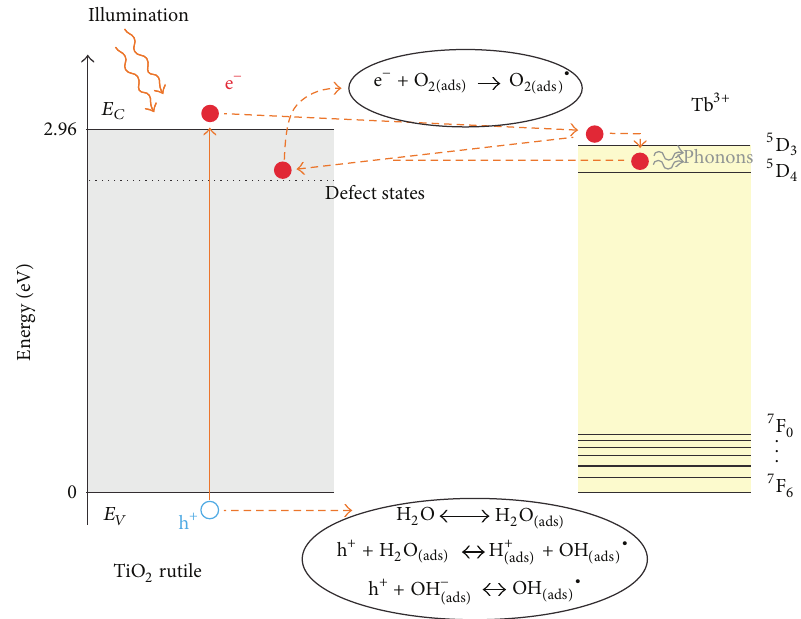
Figure 6: The scheme of processes proceeding at the TiO 2 :Tb surface with rutile structure. Designations: 𝐸 𝑐 , 𝐸 V , energy of the bottom edge of the conduction band and the top of the valence band, respectively; e − , electron; h + , hole; O 2 , oxygen; O 2∙ , oxygen radical; H 2 O, water; H + , hydrogen; OH − , hydroxide group; OH ∙ , hydroxide radical; (ads), surface